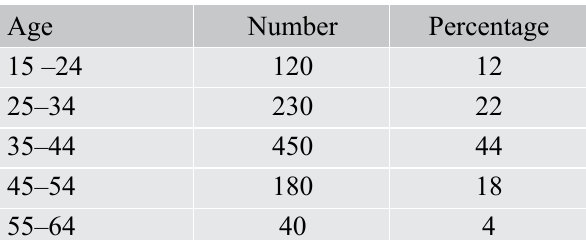
Table I: Distribution of subjects according to age